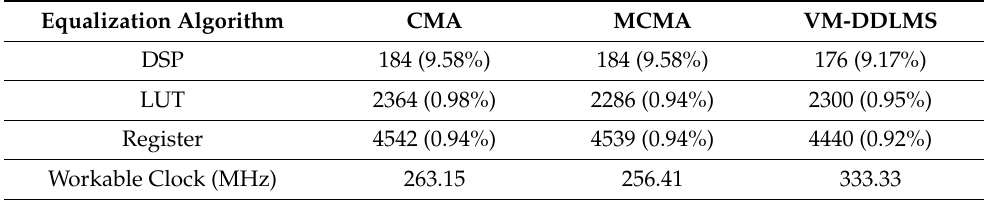
Table 2. Parallel 11th-order equalization algorithm resource